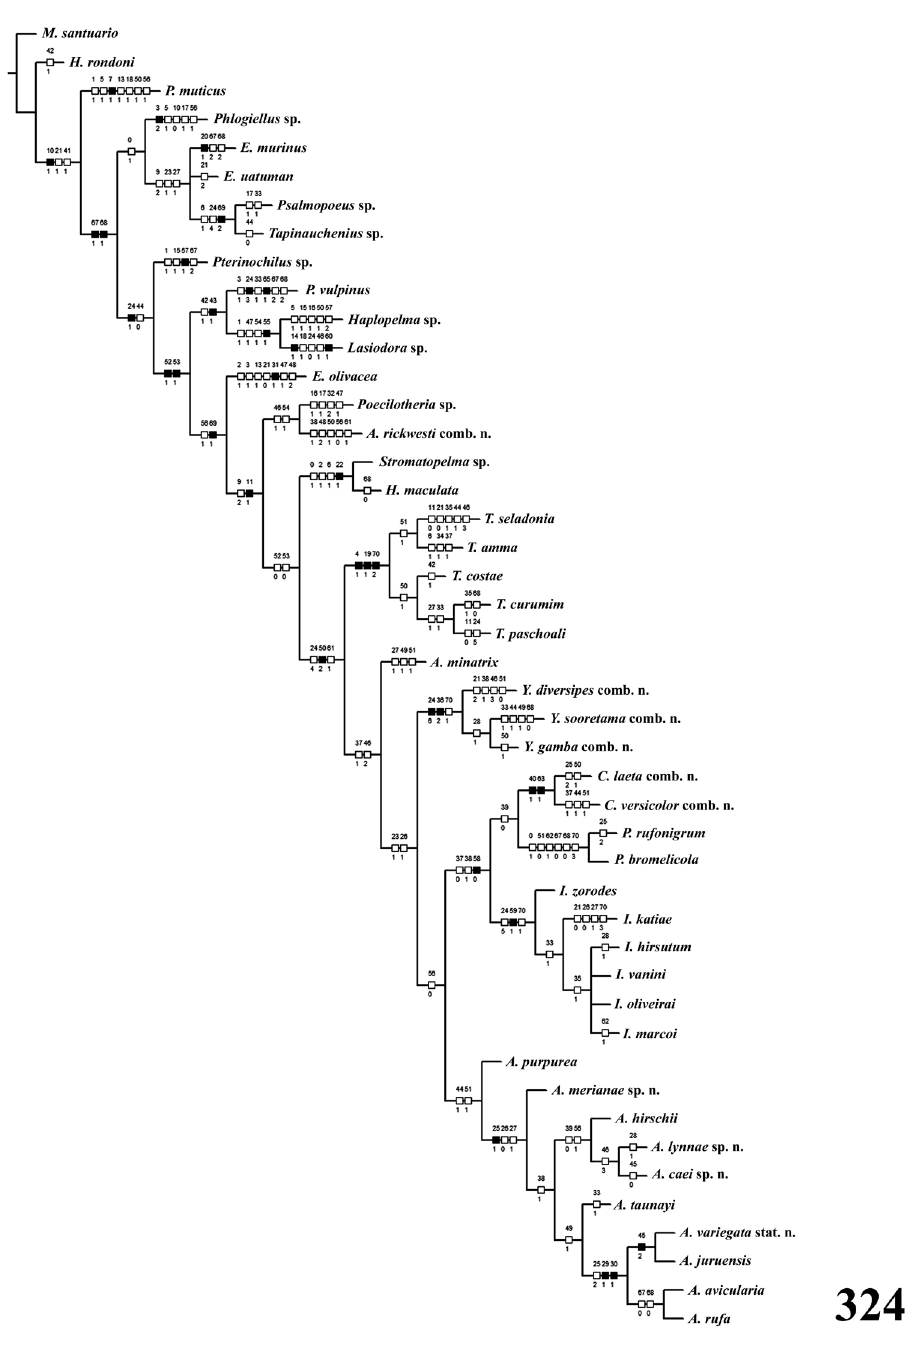
Figure 324. Strict consensus of 6 trees obtained with NONA and all characters as non-additive. Black square = synapomorphy, white square = homoplasy. Length = 229, CI = 41, RI =